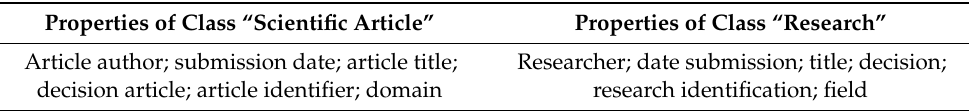
Table 3. Data properties after removing the stopping words.